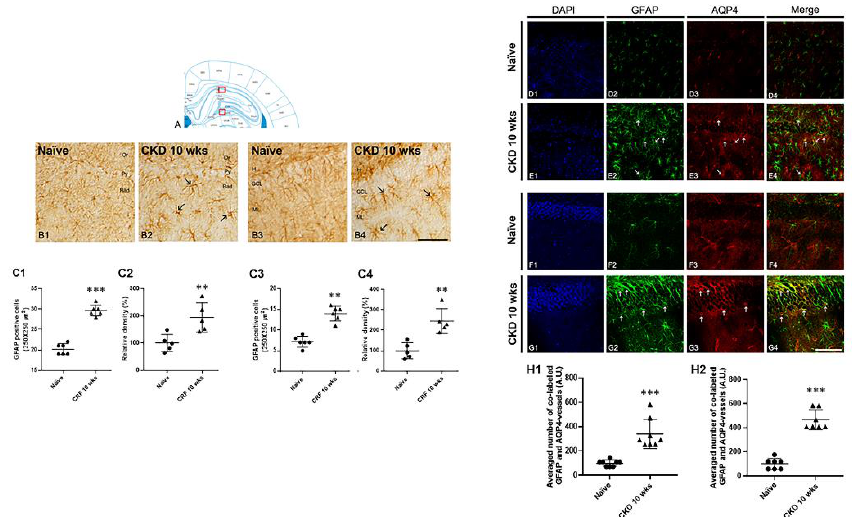
Figure 6. Gliosis in the hippocampal region of CKD model rats. Diagram of the rat hippocampus ( A ). GFAP immunoreactivity in the hippocampus of CKD 10-wk rats was enhanced in the CA1 and DG regions (arrows) compared with naïve rats ( B1 – B4 ): scale bar = 25 µ m. The average number of GFAP-positive astroglia and the densitometric analysis results of GFAP immunoreactivity were consistent with the immunohistochemical data ( C1 – C4 ). Double labeling of GFAP and AQP-4 in the hippocampal CA1 and DG regions of naïve rats ( D , F ) and CKD 10-wk rats ( E , G ): GFAP (green); AQP-4 (red); merged images (yellow); scale bar = 18.8 µ m; A.U., arbitrary unit. Data are presented as the mean and SEM. Significant differences from naïve rats ( H1 , H2 ), ** p < 0.01, *** p < 0.001 by one-way analysis of variance, IHC: n = 5/group; CA1 of double labeling: n = 8/group; DG of double labeling: n = 7/group.